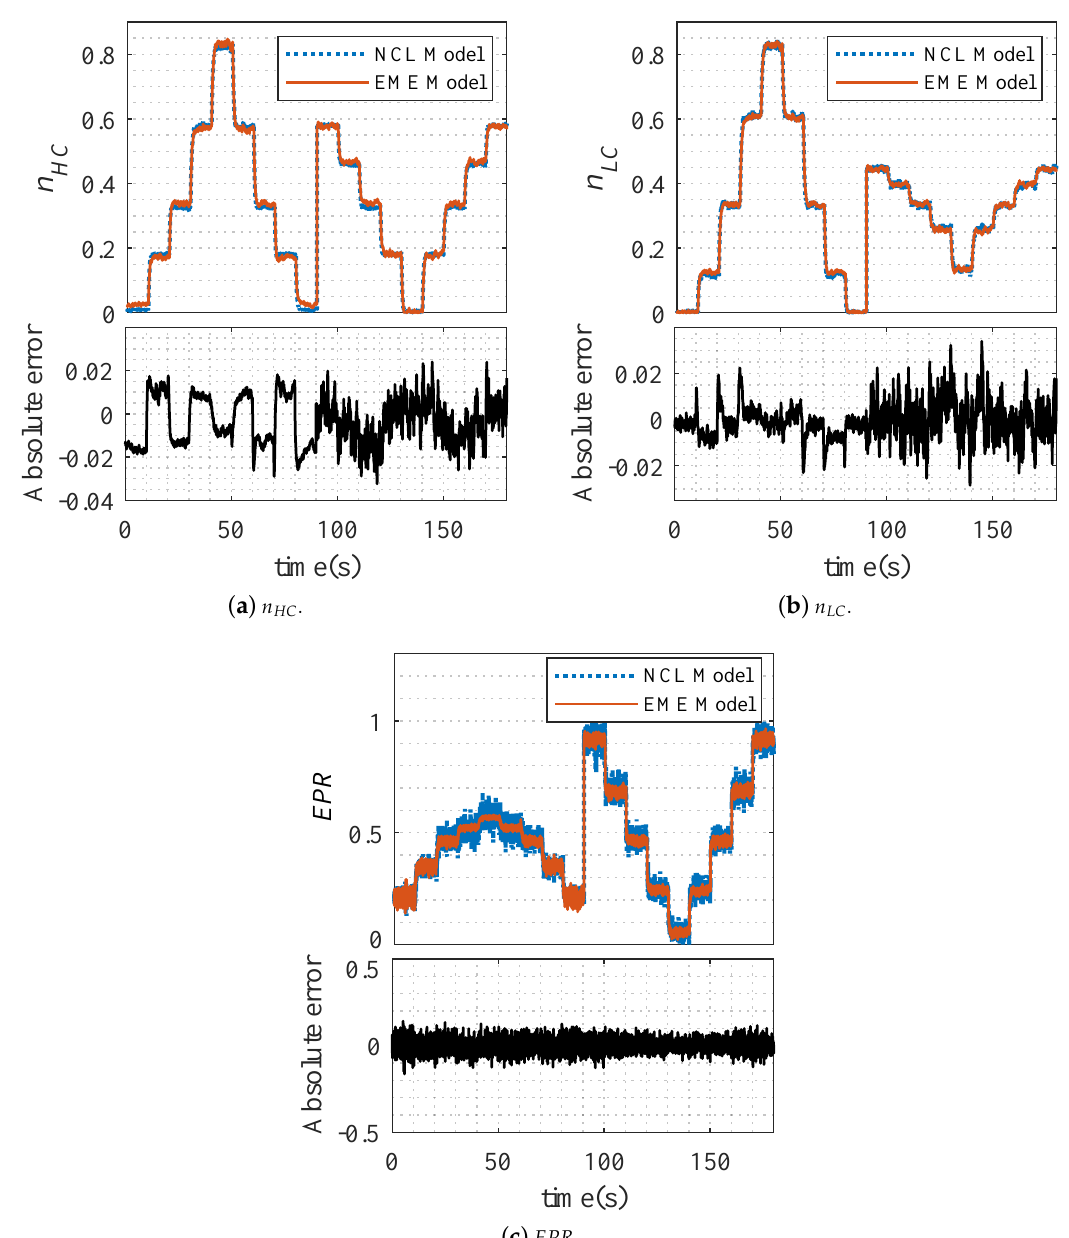
Figure 14. The validation of the EME ( α = [ n HC , A n ] ) model with noise conditions in Path 1 &